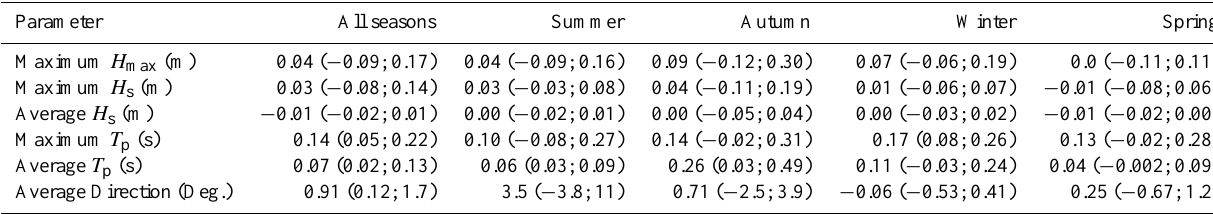
Table 3. Annual rate of change of Durban’s wave parameters. The bracketed values are the 95% confidence intervals.